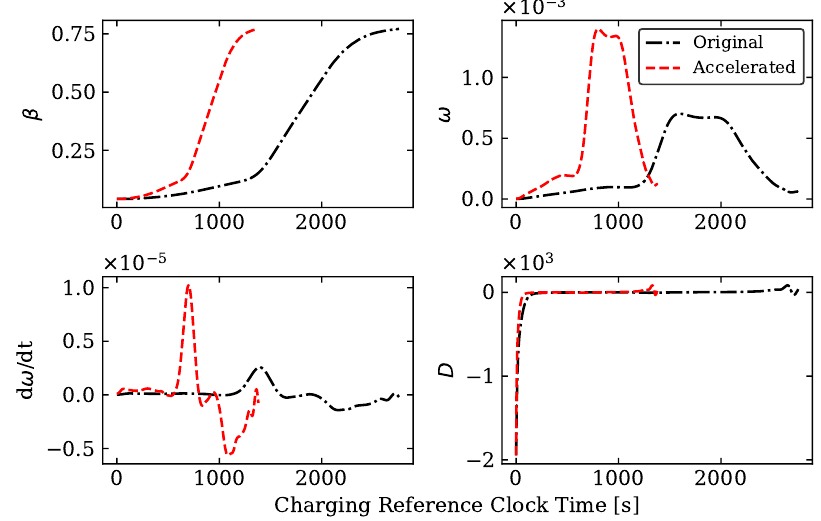
Figure 4. Scaling comparison of charging mode at the centerline, phase 1.